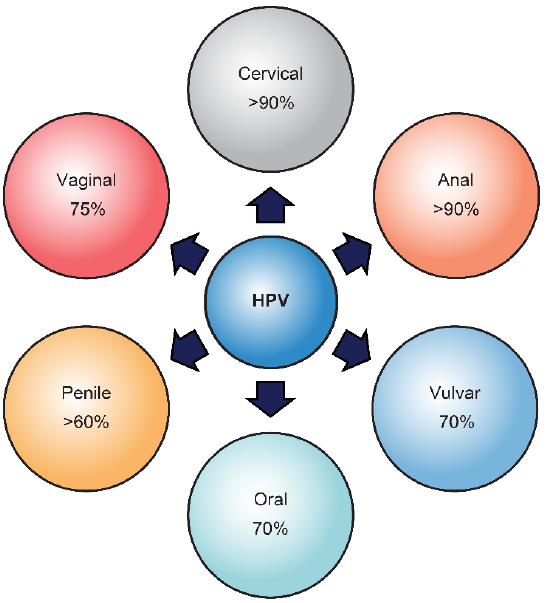
Figure 2. HPV-associated cancers. Types of cancer caused by HPV. The percentage of cancers caused by HPVs is from the United States data from the National Cancer Institute.